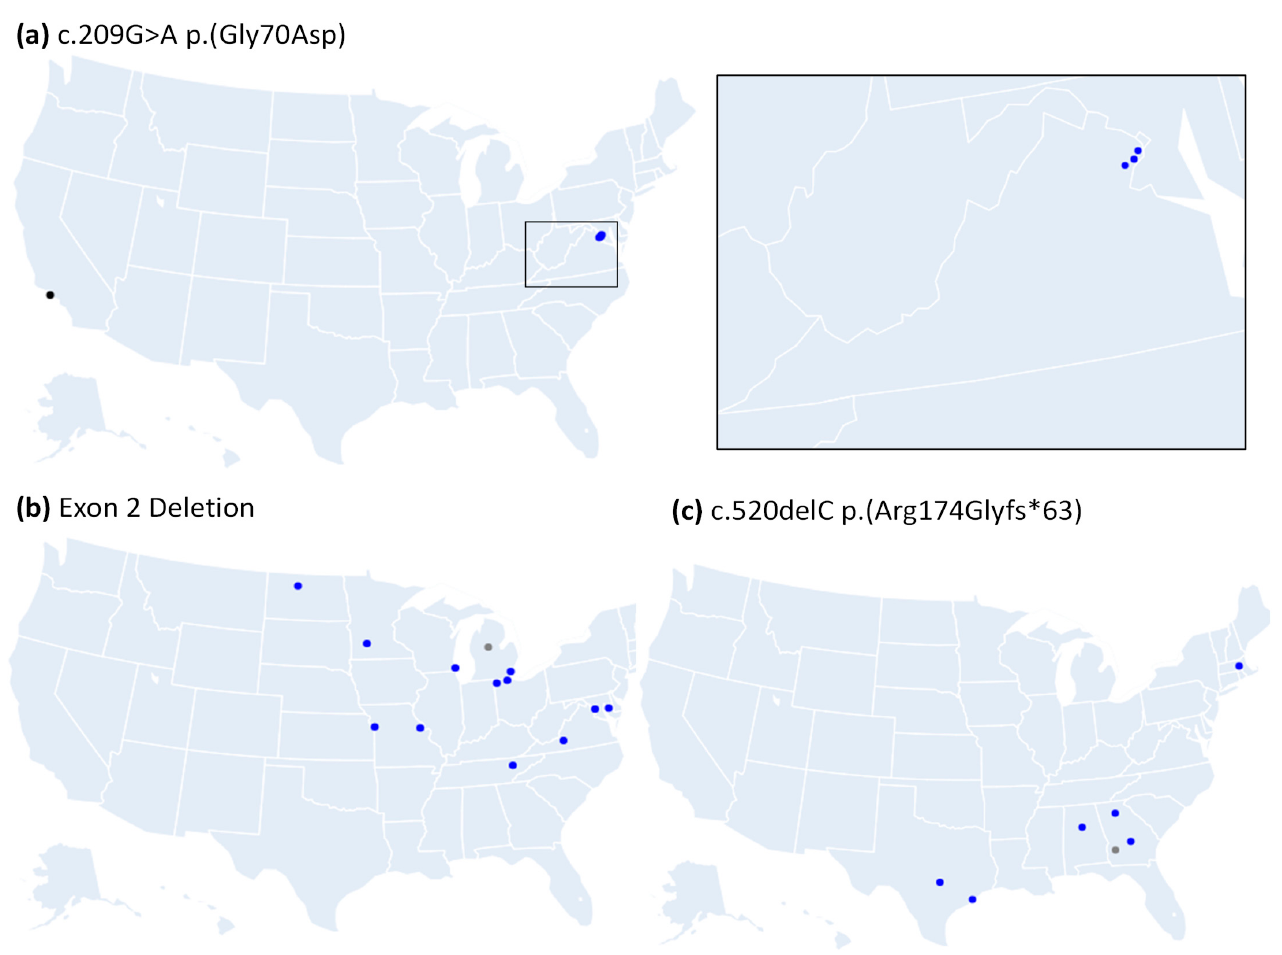
Figure 4. Geographical distribution of three recurrent variants by proband ZIP code. ( a ) Three probands with variant-specific haplotypes (Hap15) tightly cluster (blue inset); one proband with the same RS1 variant shared 2/7 haplotype markers (gray). ( b ) Twelve probands with variant-specific haplotypes are in blue (Hap4); one proband with the same RS1 variant shared 6/7 haplotype markers (gray). ( c ) Six probands with variant specific haplotypes are in blue (Hap5), and one proband shared 6/7 haplotype markers (gray).